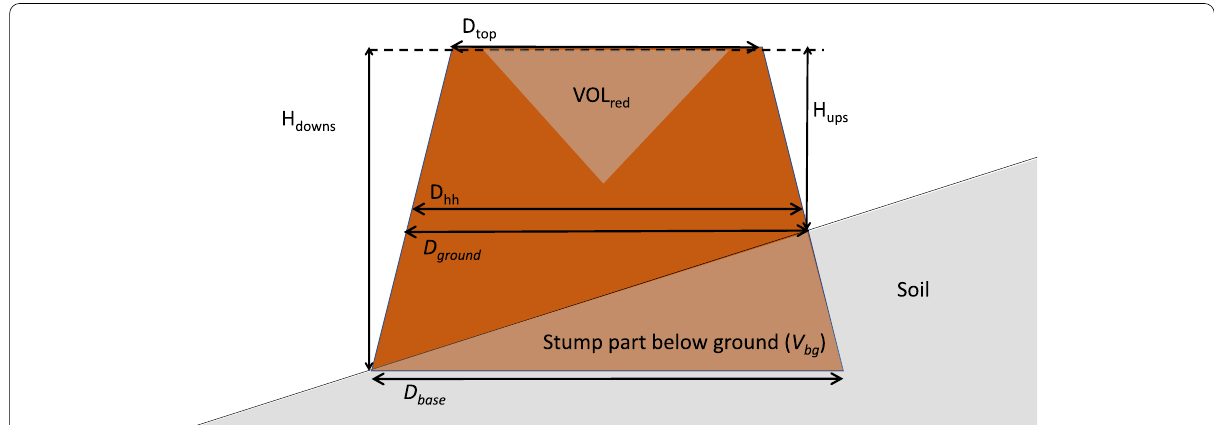
Fig. 1 Measurements on stumps in the NFI5: D top , diameter at the top of the stump; D hh , diameter at half of the maximum height, i.e., in case of uneven soil surfaces, the height on the side facing downslope; H downs , on uneven surface the maximum height; H ups , on uneven surfaces the minimum height (on even surfaces H downs H ups ); VOL red , estimated % missing volume due to cavities or in cases of uneven upper stump parts. = Derived variables: D g , diameter at upslope ground level; D base , diameter at the base of the stump; and V bg , volume of the stump that is below